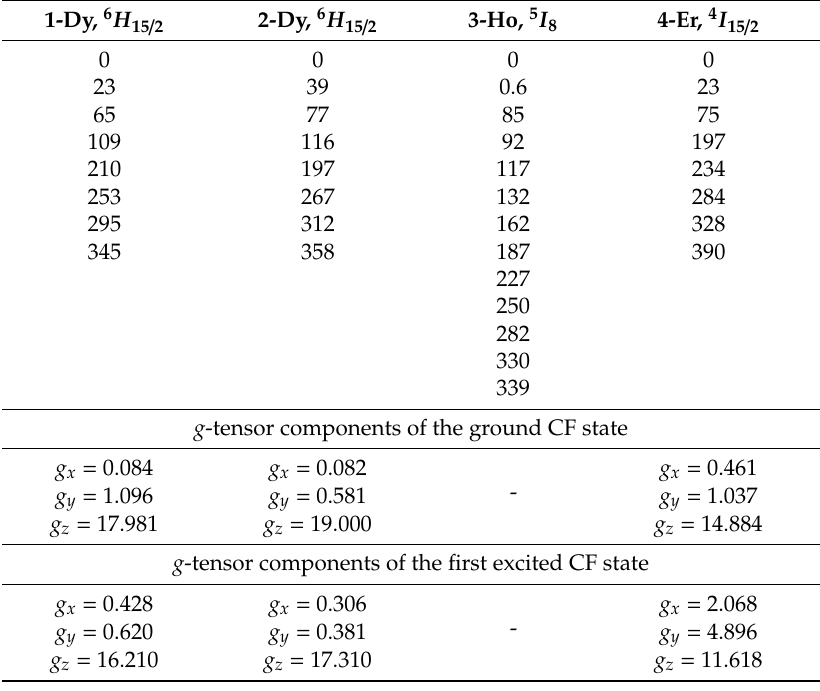
Table 3. Calculated crystal-field (CF) splitting energies (cm − 1 ) of the lowest J -multiplets of Ln 3 + ions and g -tensors of the ground and first excited CF states in 1-Dy , 2-Dy , 3-Ho and 4-Er complexes. 1-Dy, 6 H 15 / 2 2-Dy, 6 H 15 / 2 3-Ho, 5 I 8 4-Er, 4 I 15 /